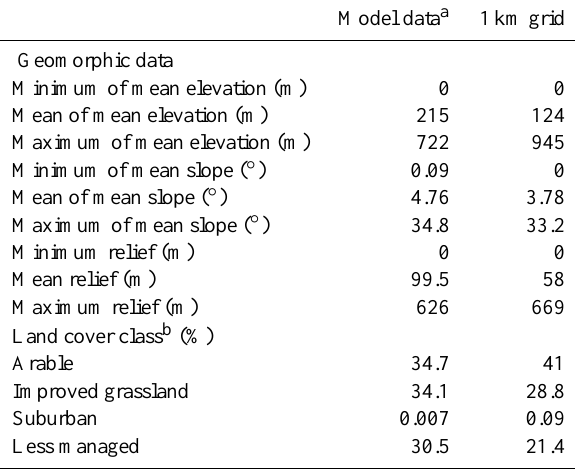
Table 3. Summary statistics for geomorphological and land cover predictors (for catchments derived from 2637 sample sites) used to form the model of stream p CO 2 , and for a 1km grid ( n =147829) across England and Wales.